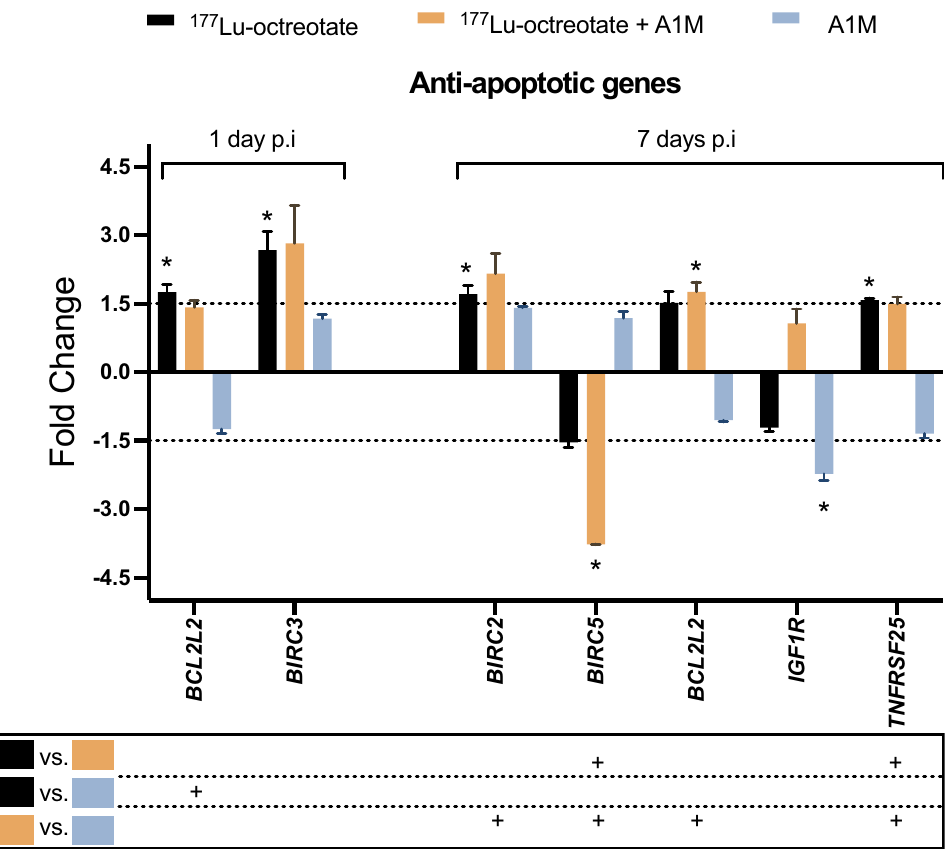
Figure 3. Anti-apoptotic response in GOT1 tumors after exposure to 177 Lu-octreotate, 177 Lu-octreotate + A1M, and A1M alone. The figure shows e xpression of all anti-apoptotis related genes with significantly different expression compared to controls (p < 0.05 and regulated |FC|≥ 1.5) in at least one of the three groups. BIRC3 and BIRC5 showed highest regulation. Dashed lines represent |FC|= 1.5, and the box beneath graphs shows results from group comparisons with one-way ANOVA tests, where “+” represents a statistically significant difference (p < 0.05) between groups. Tumors from three and two mice were used in the treatment and control group, respectively. Error bars represent SEM. *p < 0.05 (0.017–0.048). Statistical analysis was performed using